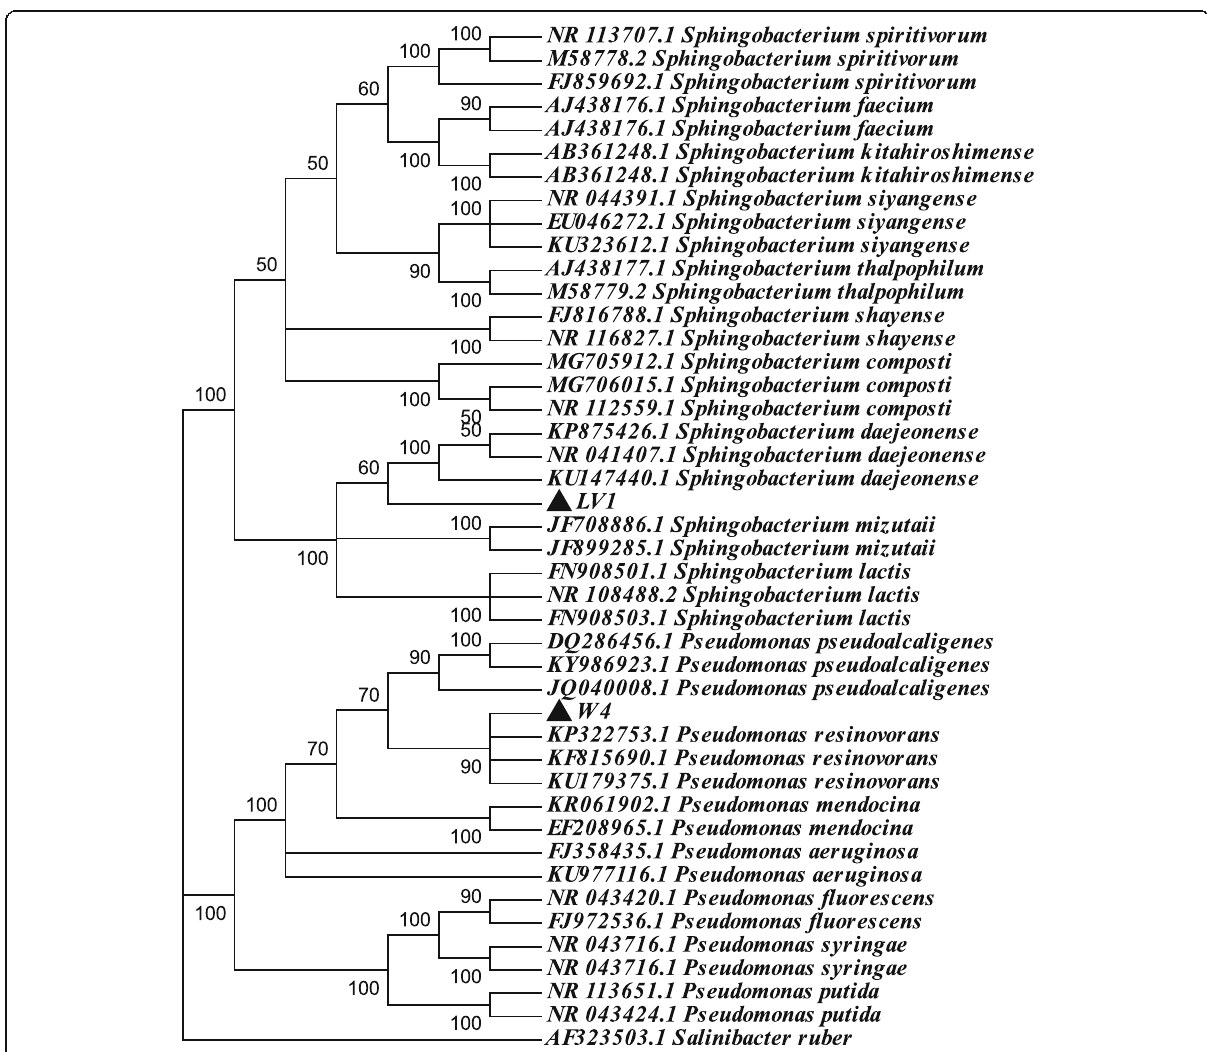
Fig. 2 Phylogenic relationships of Pseudomonas resinovorans (W4) and Sphingobacterium daejeonense (LV1) based on 16S rDNA sequences (maximum likelihood method). Numbers on the branches indicate bootstrap values. Salinibacter ruber was used as a